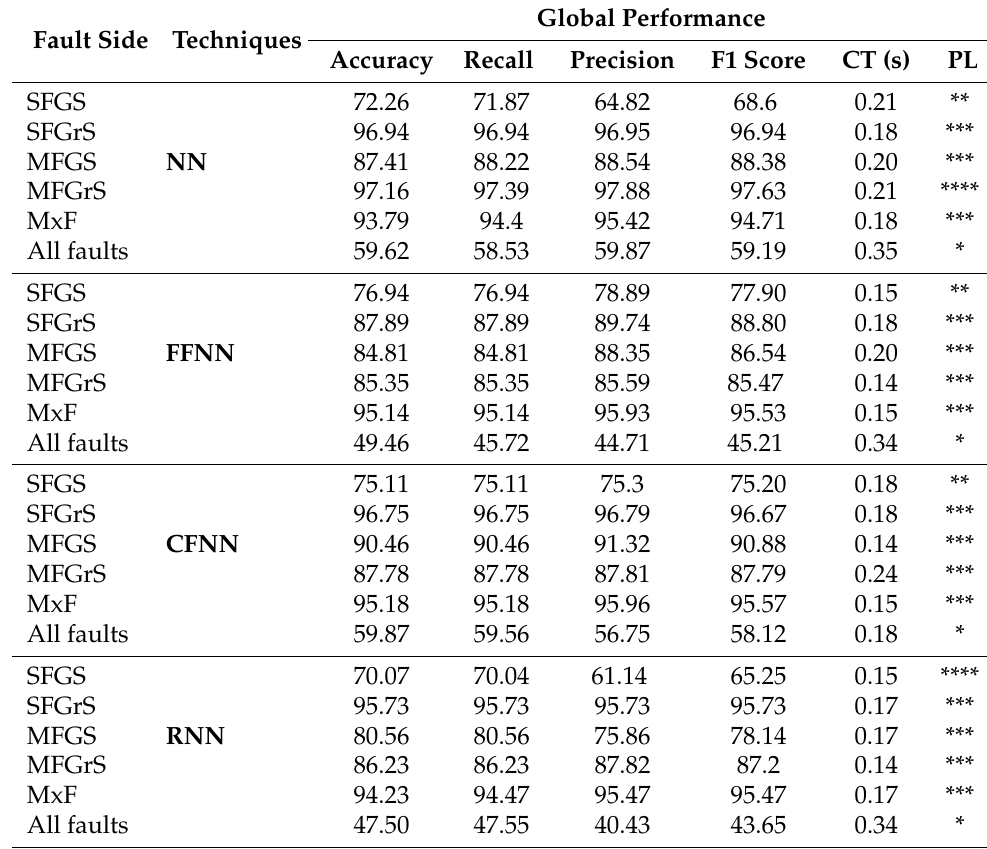
Table 6. Performance comparison of conventional techniques.